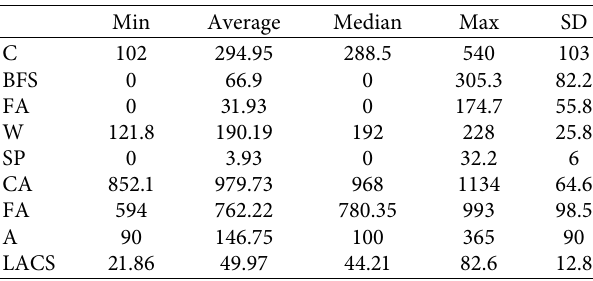
Figure 1: Illustration of the FNN algorithm used in this study, including 8 inputs. Table 2: Summary of the statistical information of the database used in the present